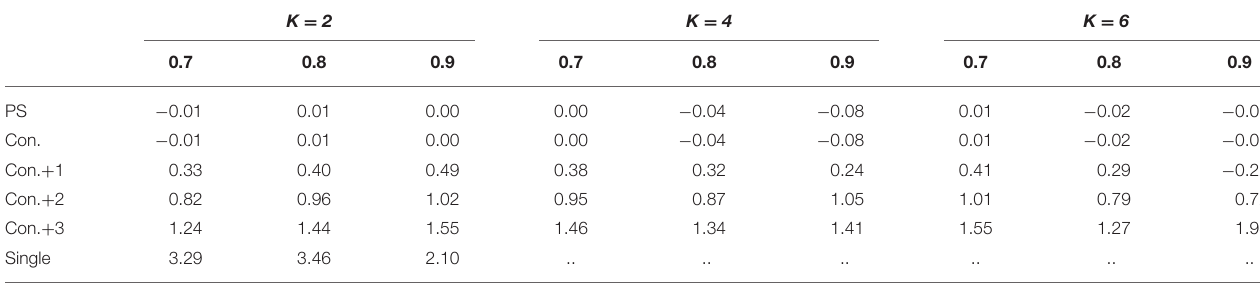
TABLE 1 | Percentage bias* accompanying Figures 18A–C